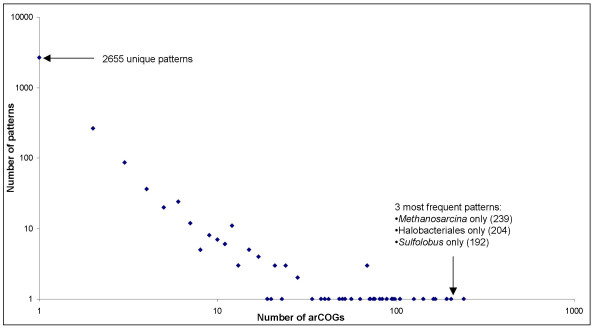
Distribution of phyletic patterns by the number of arCOGs. A log-log plot.